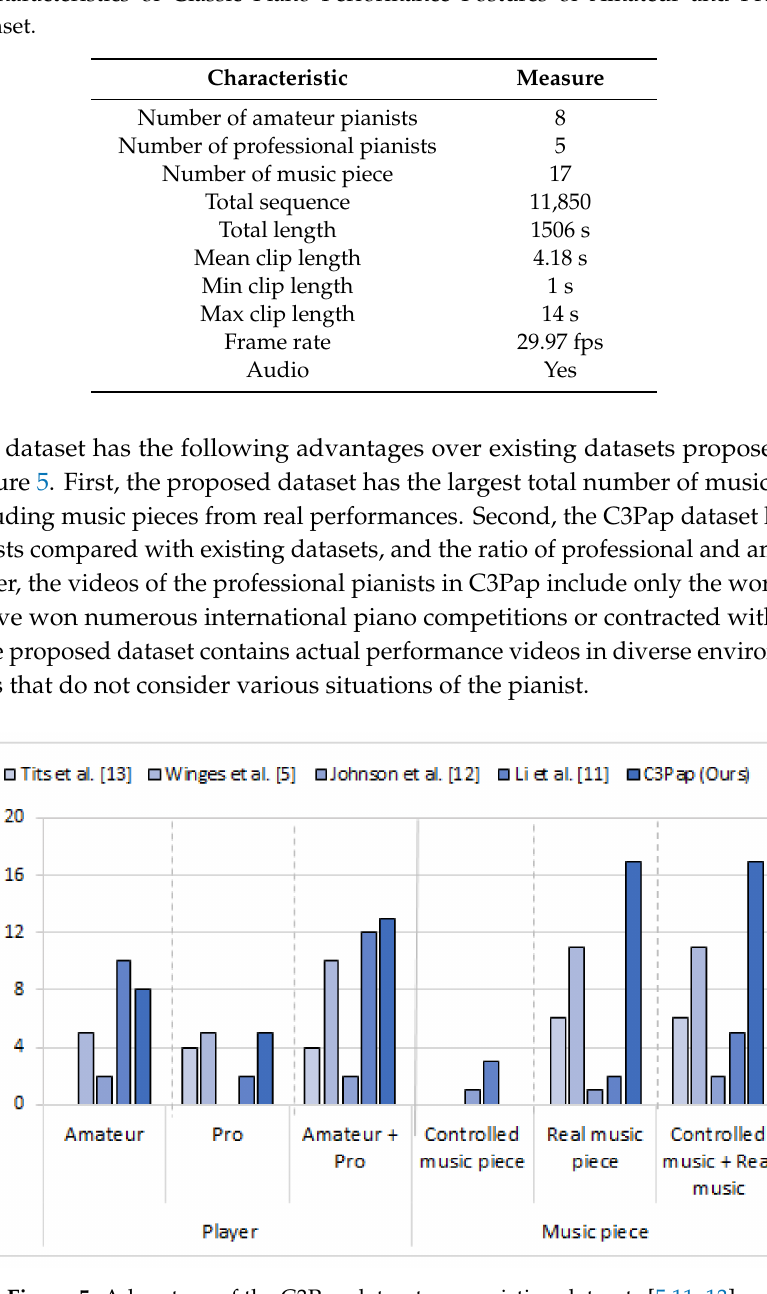
Figure 5. Advantage of the C3Pap dataset over existing datasets